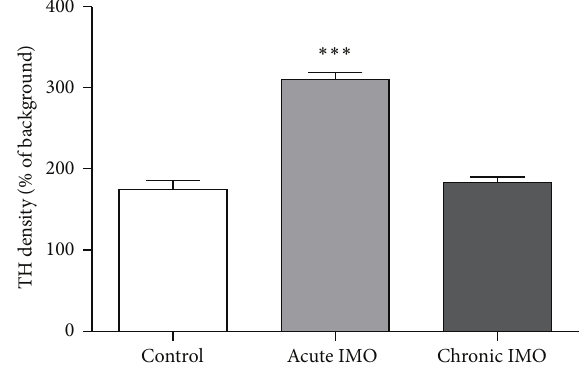
Figure 6: Mean ( ± SEM) quantification of TH expression in the LC of the control group and groups subjected acute and chronic IMO. Acutely stressed rat expressed significantly increase in TH density whereas chronically stressed animals showed no change. ( 𝑛 = 4 - 5 per group) ∗∗∗ 𝑃 < 0.001 versus control;